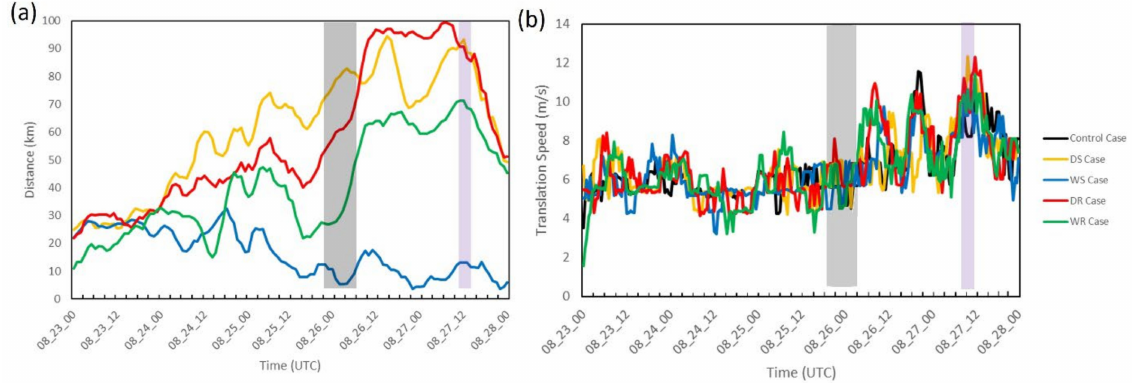
Figure 3. ( a ) Distance of storm center from that of the Control case of all four experiments; ( b ) Time series of translation speed (m s − 1 ) of all cases with a grey box showing the range of Florida landfall times and purple box showing the range of South Carolina landfall